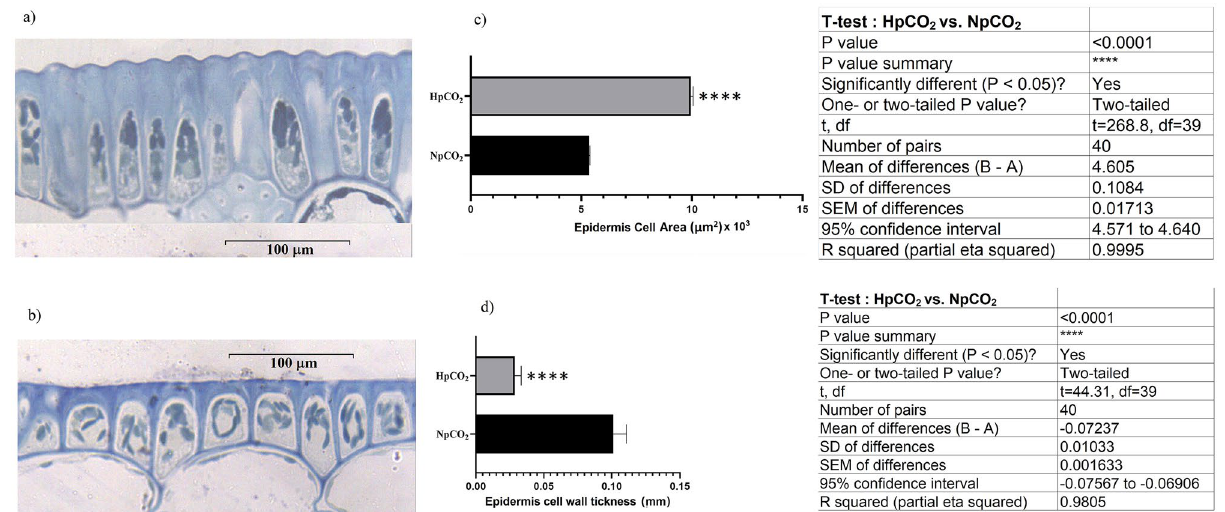
Figure 5. Cytological measurements of leaf epidermis of Cymodocea nodosa plants growing in normal and high p CO 2 environments. Epidermal leaf cell microphotographs of C. nodosa growing in normal ( a ) and high ( b ) p CO